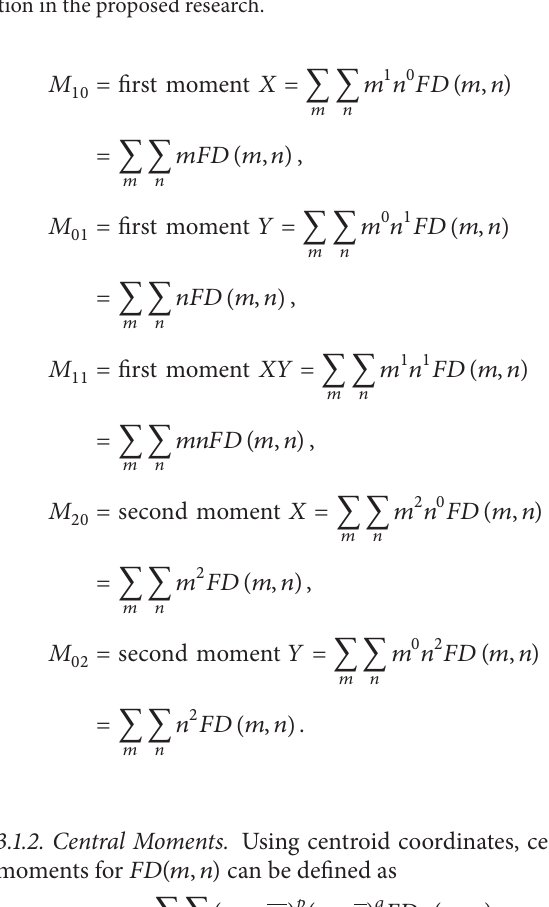
Figure 4: Flow of moments calculation in the proposed